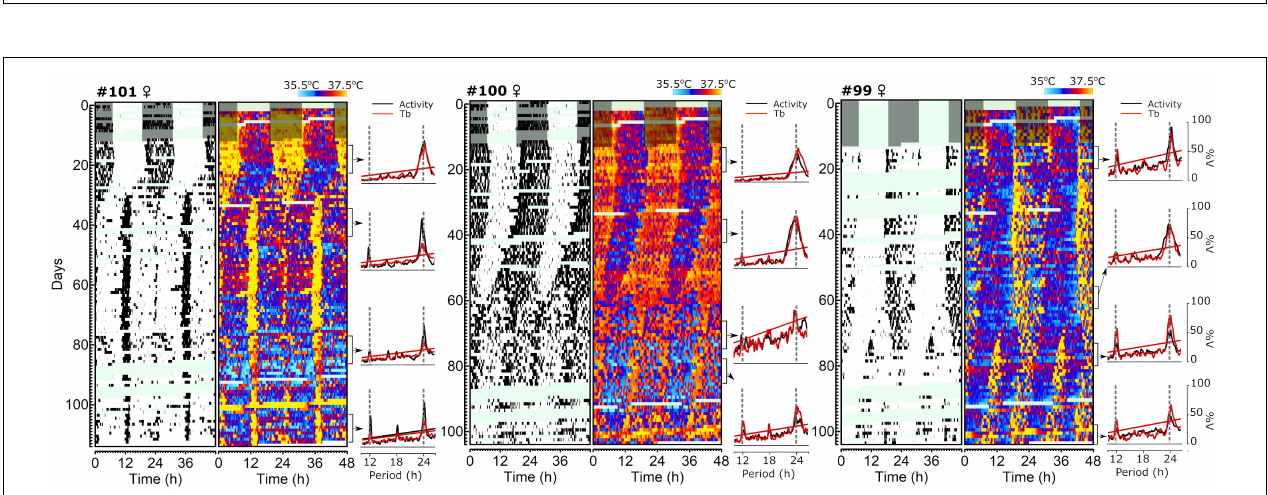
FIGURE 3 | Aftereffects of natural photoperiods in tuco-tucos captured in summer and winter and transferred to lab DD. Representative double-plotted actograms of summer- (upper panel) and winter-caught (lower panel) tuco-tucos under DD. At the right, boxplots illustrate the duration of daily lab-activity ( α ) displayed during the aftereffects of natural entrainment, compared between summer ( n = 17) and winter ( n = 18) animals.